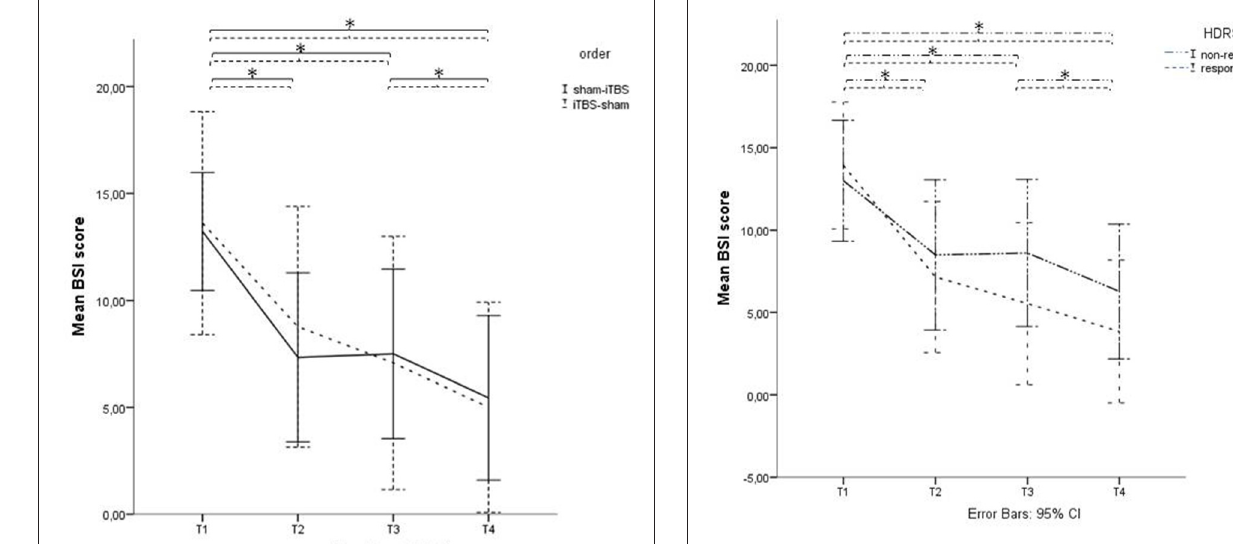
FIGURE 3 | BSI score in Hamilton Depression Rating Scale (HDRS)- responders and non-responders. Graphical representation of the BSI mean scores with Time (baseline (T1), after 1 week of stimulation (T2), after finishing the treatment protocol (T3) and 2 weeks later (T4)) as within-subjects variable and HDRS responders on T4 as between-subjects factor. ∗ Indicates significant